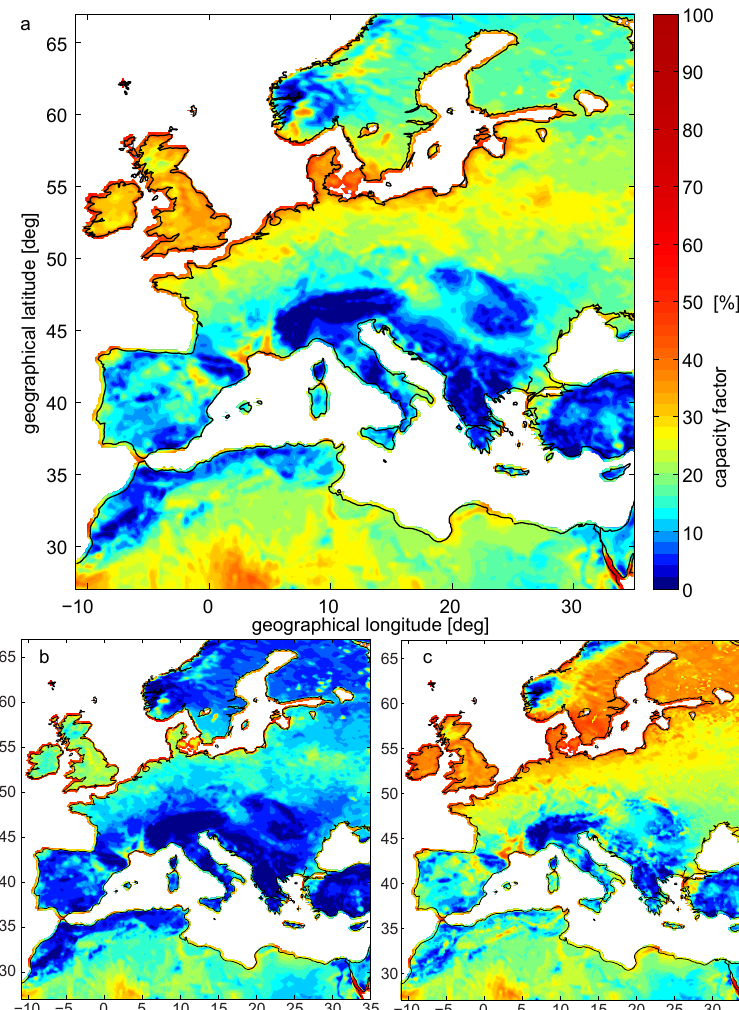
Fig. 1. Mean capacity factor (fraction of maximum capacity) using an exemplary power curve for the period 9 November 2010 through 8 November 2012 (a) from ECMWF 100m wind, (b) from ECMWF 10m wind multiplied by 1.28 as in Kiss and J´anosi (2008), and (c) from ECMWF 10m wind extrapolated logarithmically. The capacity factor scale is logarithmic. 9